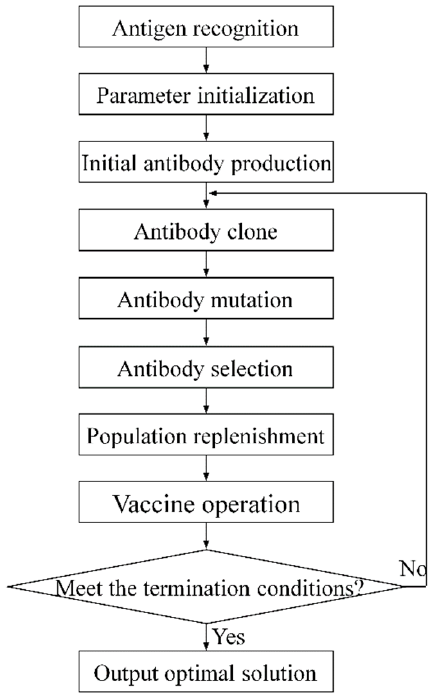
Figure 4. Flow of the basic immune clonal optimization algorithm.